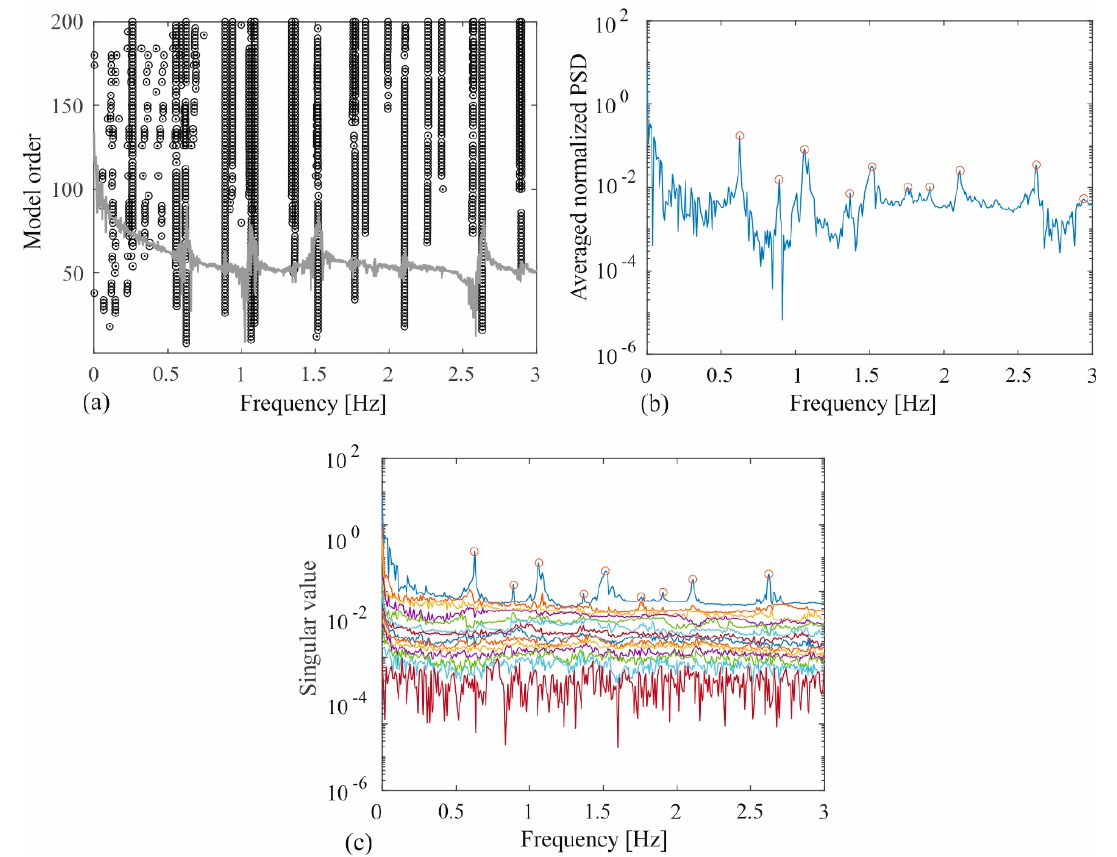
Figure 7. Setup 1: Stabilization diagram ( a ), averaged power spectral density functions ( b ), singular values ( c ).